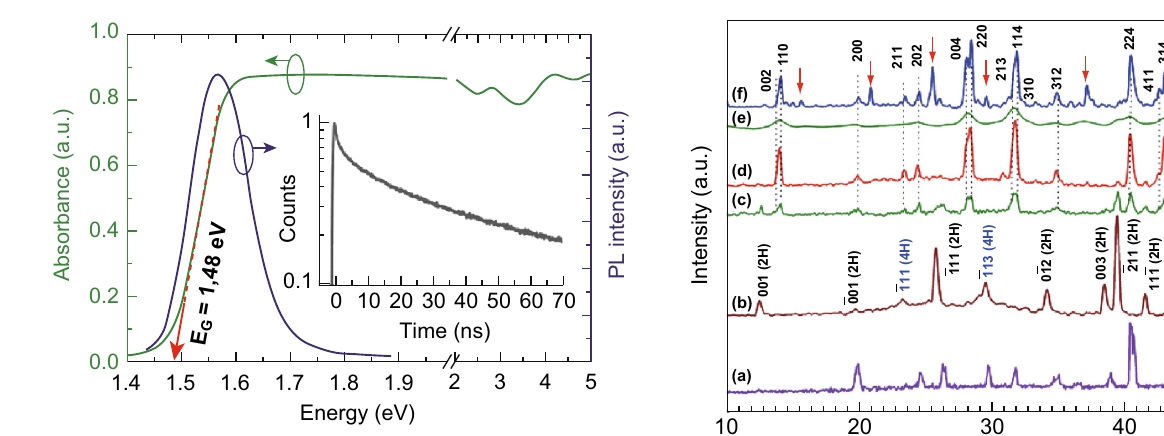
Fig. 13 UV–Vis absorption (green peak) and PL (blue) spectra of as- ground MAPbI 3 measured at ambient temperature: fluorescence decay excitation measured at the 3.05 eV (inset view). Reproduced with permission Ref. [29]. Copyright (cid:2) 2015 The Royal Society of Chemistry. (Color figure online)